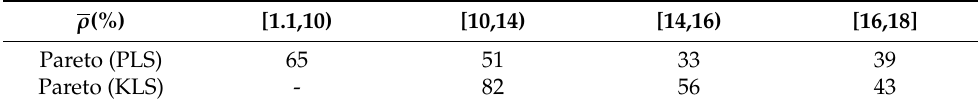
Table 5. The distribution for Pareto solutions of ρ for